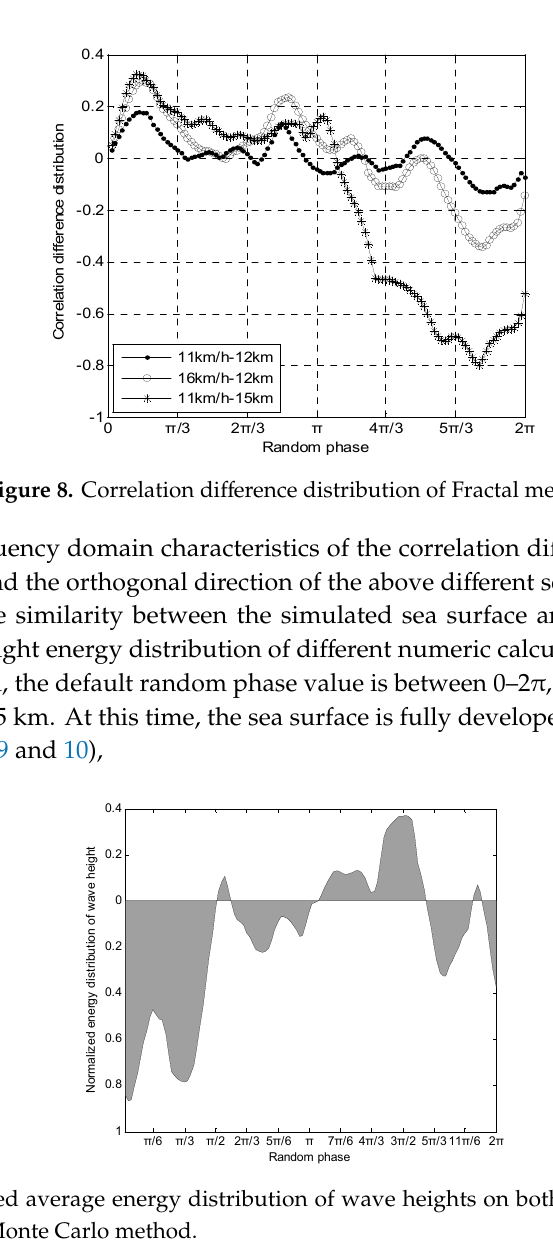
Figure 7. Correlation difference distribution of Monte Carlo method.